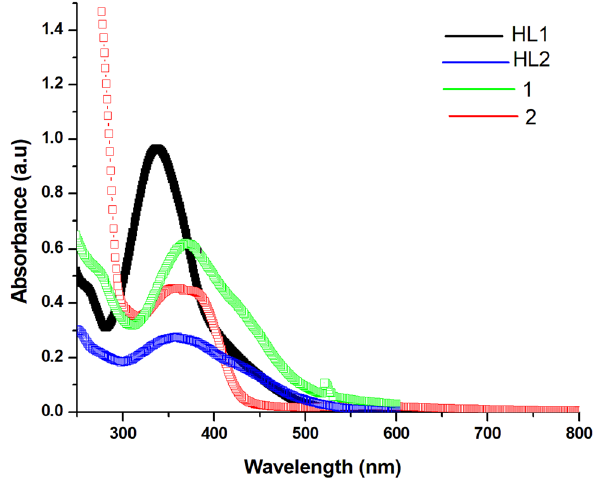
Figure 1: Absorption property of complexes and ligands in DMF